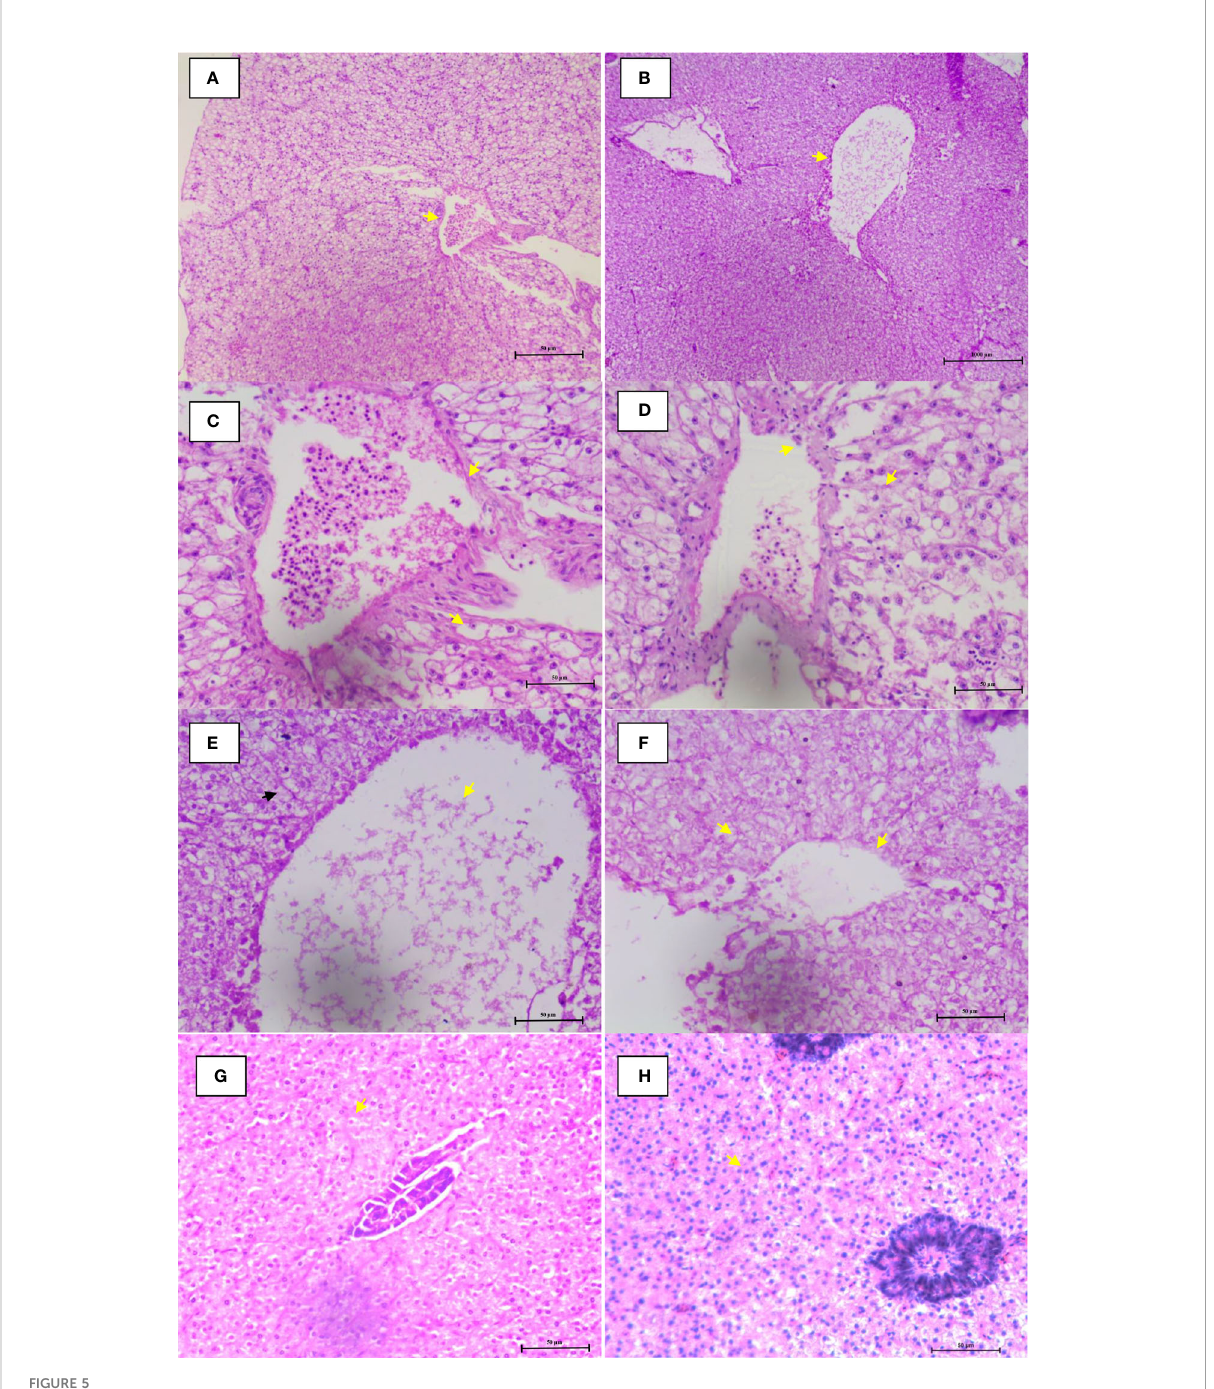
FIGURE 5 Microphotographs of histological section (H&E) of liver during co-infection. (A, B) Lymphocytes migrated from blood vessel and central vein were engorged with blood cells. (C – F) Hemorrhage, nuclear pyknosis, degenerated nuclei, blood congestion, degenerated hepatocytes, and vacuolation were observed. (G, H) Control group fi sh liver tissue appearing normal with intact hepatocytes. The arrowhead in fi gures (A – H) represents the cellular changes associated with co-infection in P.